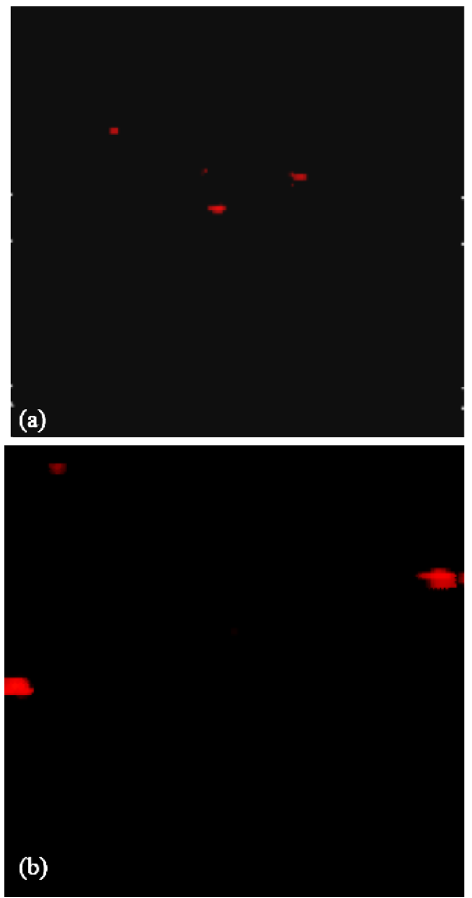
FIG. 2. (Color) E maps for (a) SCNb1 and (b) SCNb5, over the area of ð 5 (cid:5) 5 Þ mm 2 using a 100 (cid:1) m conical anode at tip-to- sample distance of 25 (cid:1) m in (a) and 20 (cid:1) m in (b). The red dots reveal five and three emitters at onset fields (for 2 nA) of about 200 and 250 MV = m , respectively.